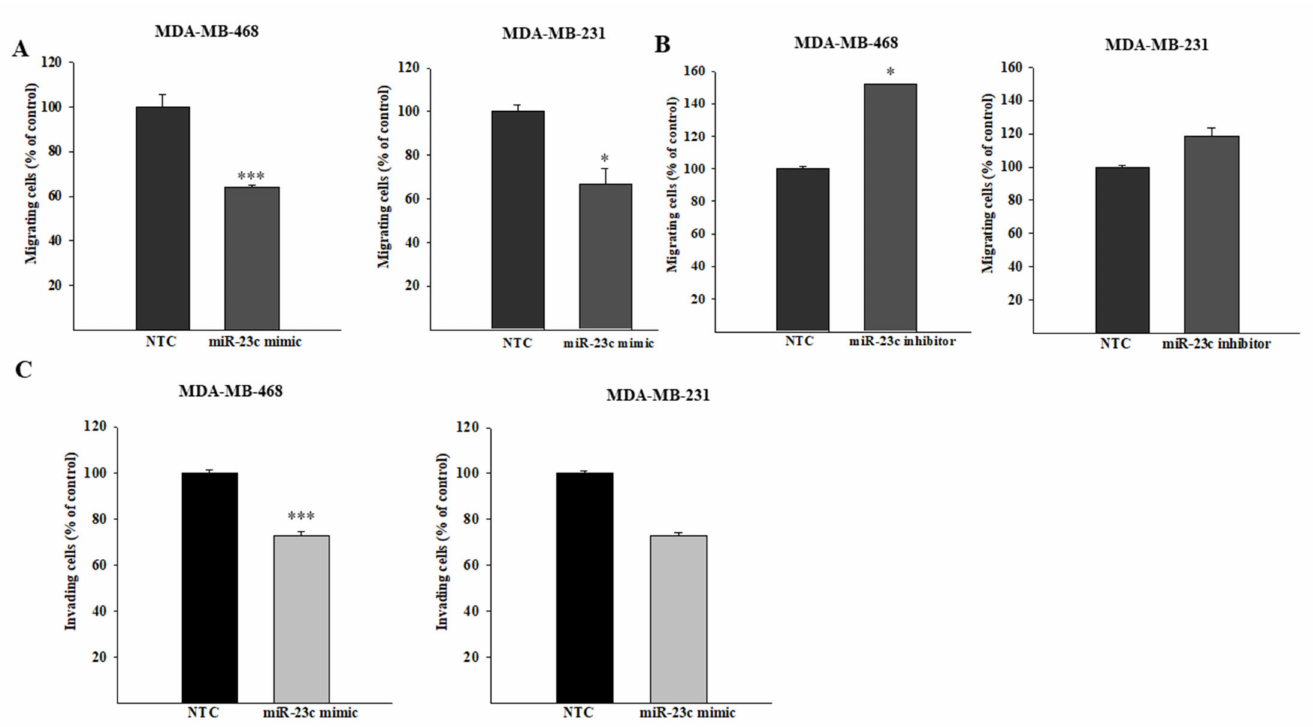
Figure 5. MiR-23c regulates migration and invasion of breast cancer cells. MDA-MB-468 and MDA- MB-231 cells were transfected for 72 h with miR-23c mimic ( A ) or inhibitor ( B ) and their respective non- targeting controls (NTCs) and then allowed to migrate through an insert toward serum-containing medium for 16 h (* p ≤ 0.05 and *** p ≤ 0.001; Student’s t -test). ( C ) The invasive ability of MDA-MB- 468 and MDA-MB-231 cell lines to transfect miR-23c mimic or NTC was determined using a Boyden chamber-based colorimetric assay (*** p ≤ 0.001; Student’s t